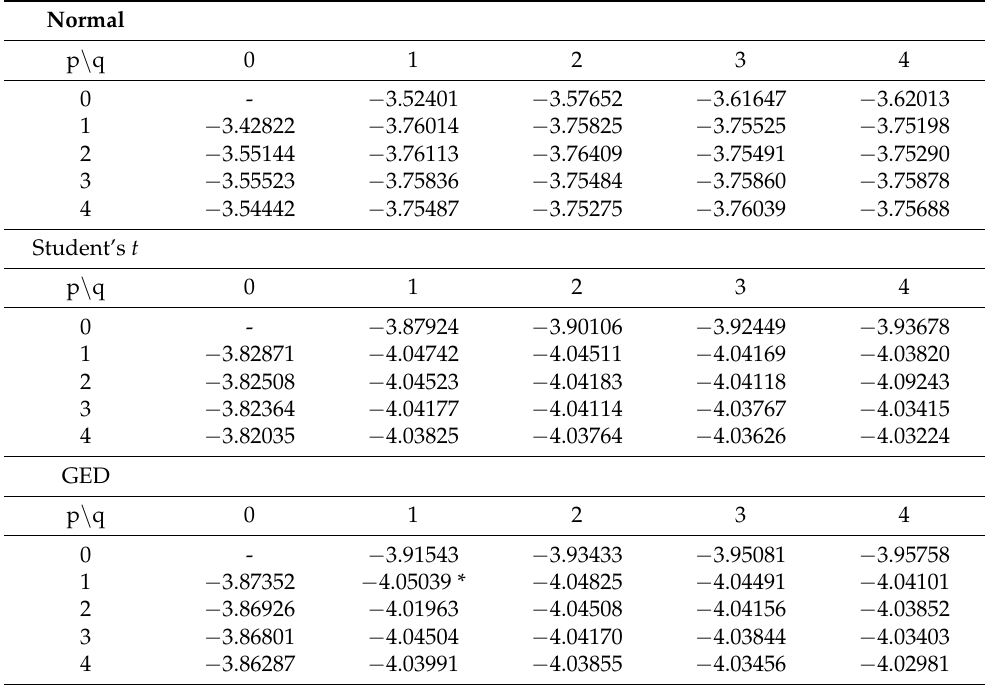
Table 3. BIC for different EGARCH(p,q) using normal, Student’s t and generalized error distribution (GED). The model that minimizes the BIC is the EGARCH(1,1) utilizing GED and the matching BIC statistic is marked with an